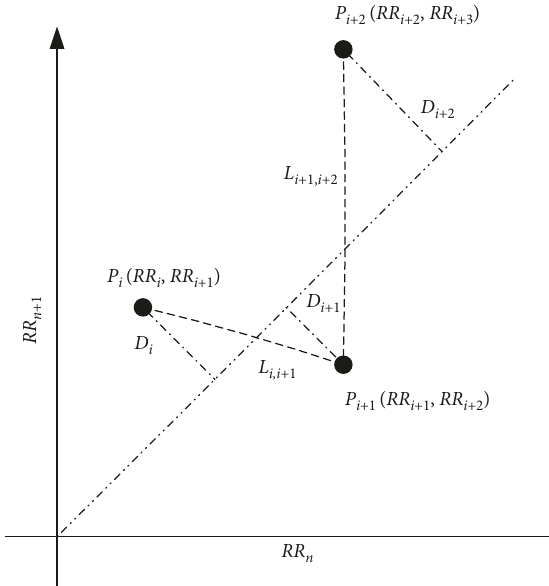
Figure 2: The positional relationship of consecutive points in the Poincar´e